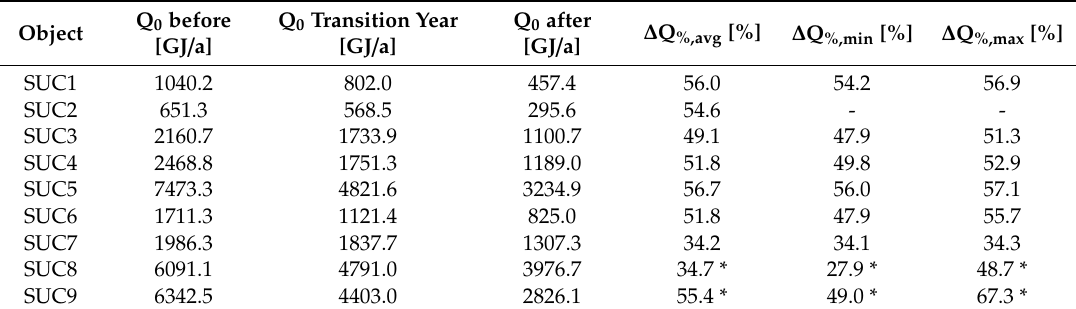
Table 6. Averaged values of the Adjusted Energy Consumption before, during and after the transition year together with comparison of the energy savings.